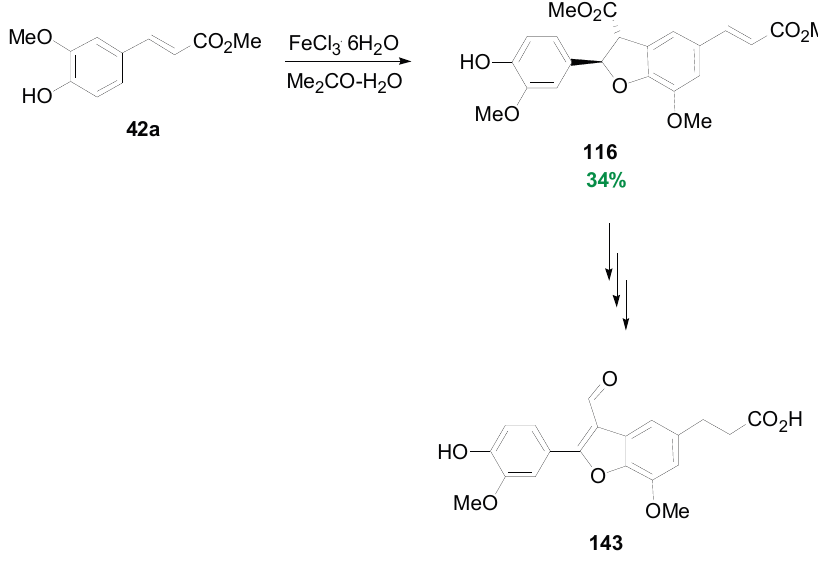
Scheme 55. Synthesis of salvinal ( 143 ) through FeCl 3 -mediated POC of Me-Fer ( 42a ).